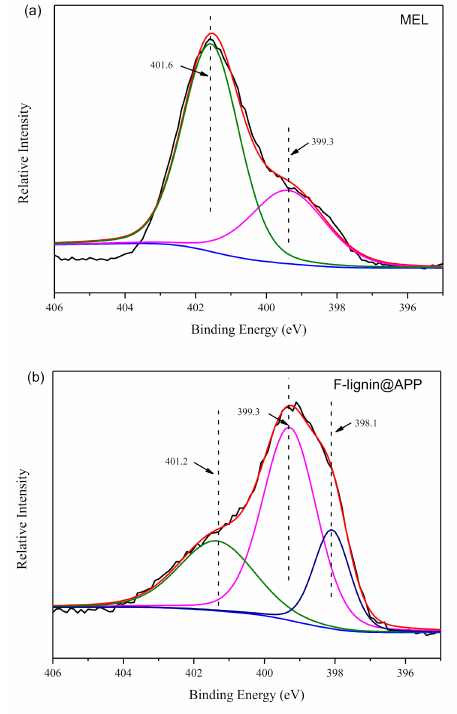
Figure 2. N 1s spectra of ( a ) melamine (MEL) and ( b )